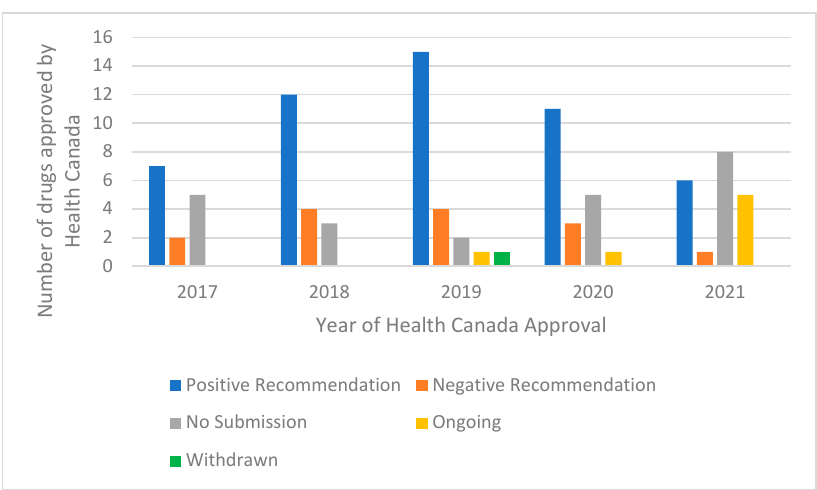
Figure 3. CADTH recommendation by year of Health Canada from 1 January 2017 to 31 October 2021.